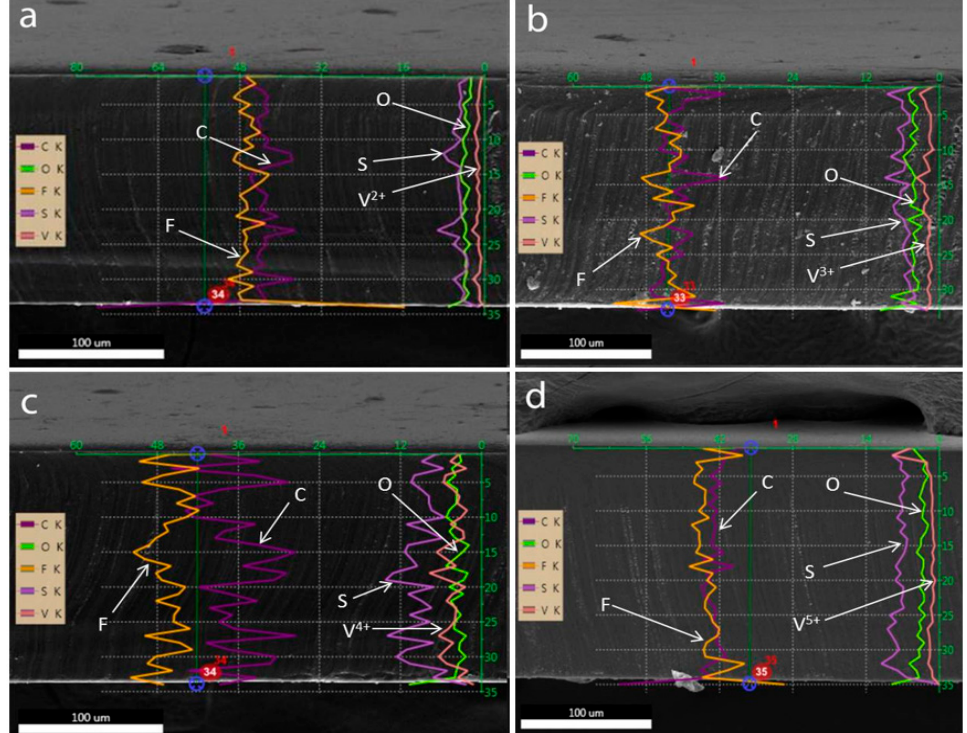
Figure 4. Results of EDS line-scan along the thickness of the Nafion membrane samples after being treated in solutions of different vanadium ions: ( a ) V 2+ , ( b ) V 3+ , ( c ) VO 2+ , and ( d ) VO 2 + solution in 2 M H 2 SO 4 ,